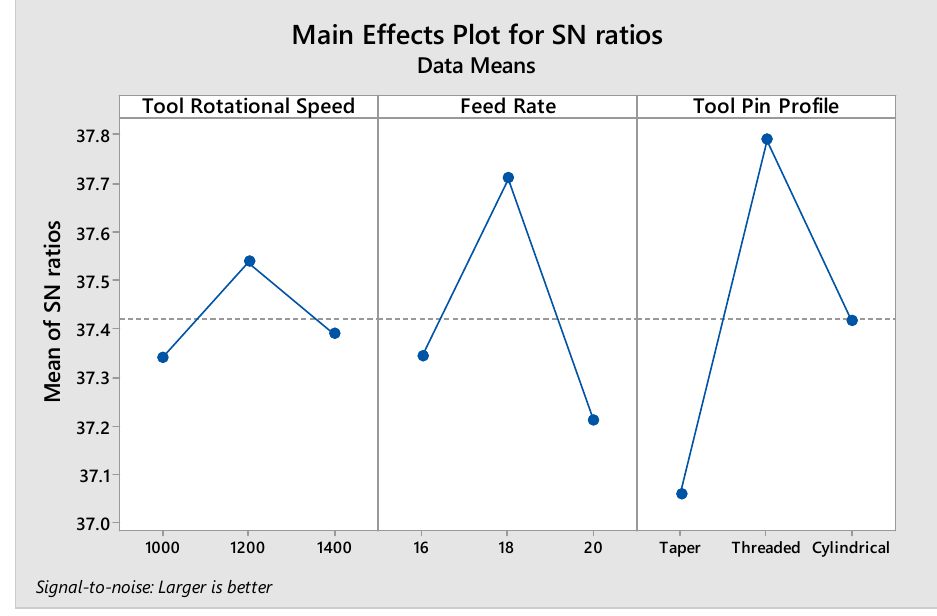
Figure 5. Main effect plot of signal-to-noise ratio for hardness (weld zone). Table 5. Tensile strength and hardness S/N ratios.